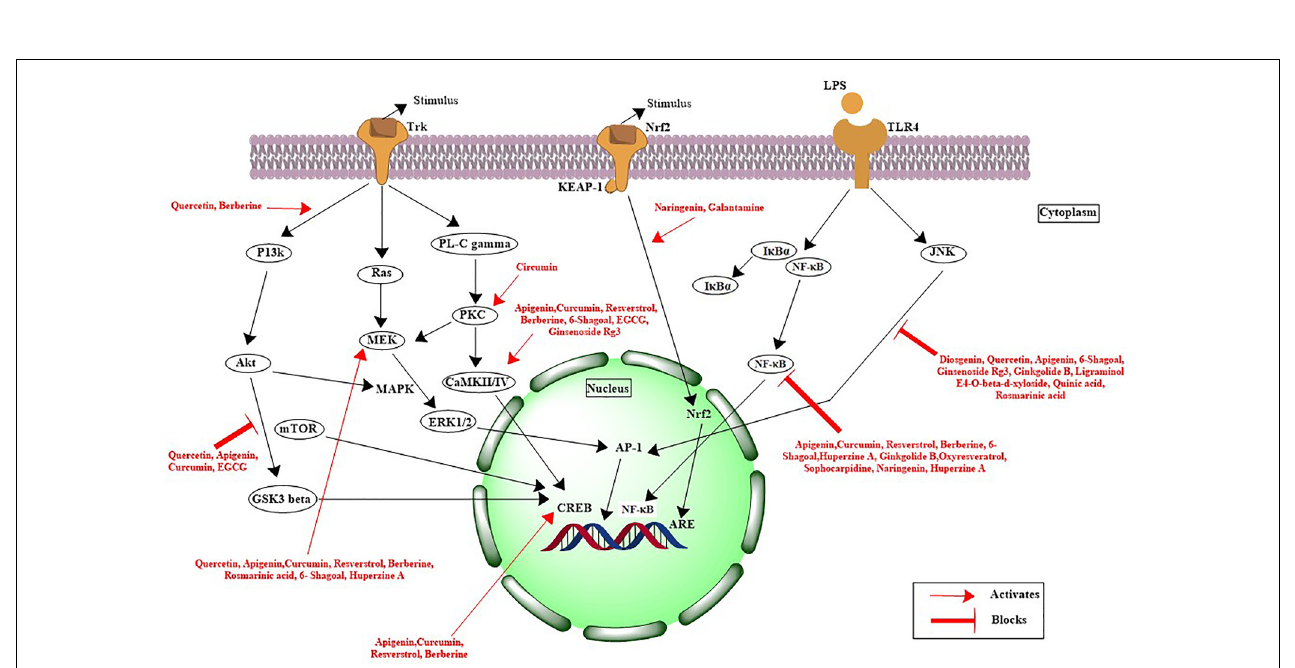
FIGURE 3 | Mechanistic pathways for natural products involved in neuroprotection against Alzheimer’s disease.